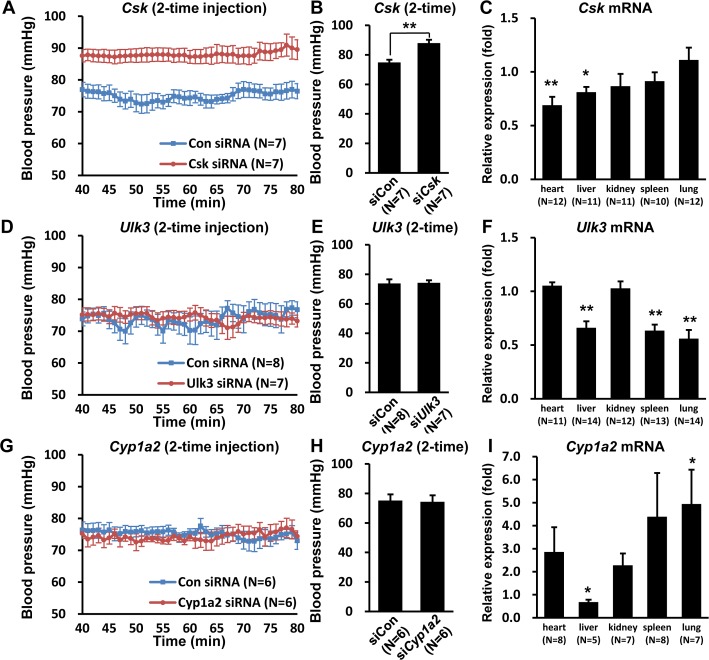
Increase in blood pressure in Csk siRNA-injected mice.(A, D, and G) The line graph shows blood pressure as the average value at each minute from 40 min to 80 min after anesthesia in (A) 2- time Csk siRNA-, (D) 2-time Ulk3 siRNA-, and (G) 2-time Cyp1a2 siRNA-injected mice. (B, E, and H) The bar graph shows the mean blood pressure for each group from 40 min to 80 min. (C, F, and I) Graphs show the relative expression of candidate gene mRNA in each tissue after 2-time siRNA injection. * P<0.05, ** P<0.01 versus respective controls.